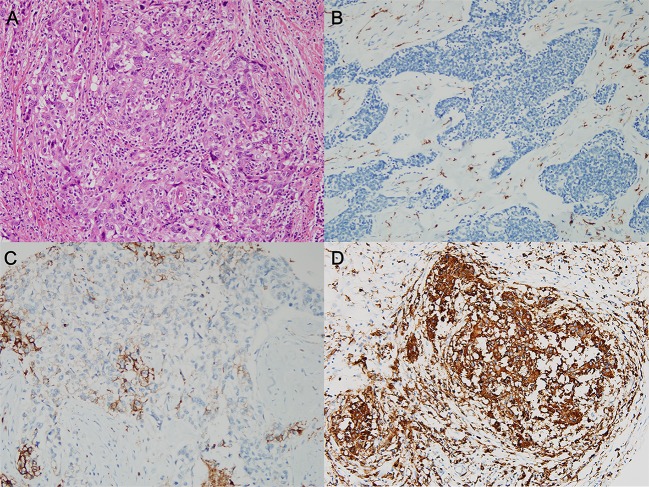
Representative image of triple-negative breast cancer (A) hematoxylin-and-eosin-stained slide and the three degrees of major histocompatibility complex (MHC) class II expression in tumor cells. (B) No MHC-II expression and (C) lower and (D) higher expression than the mean value of the immunoreactive score, which was generated as the product of intensity and percentage of positively stained cells.